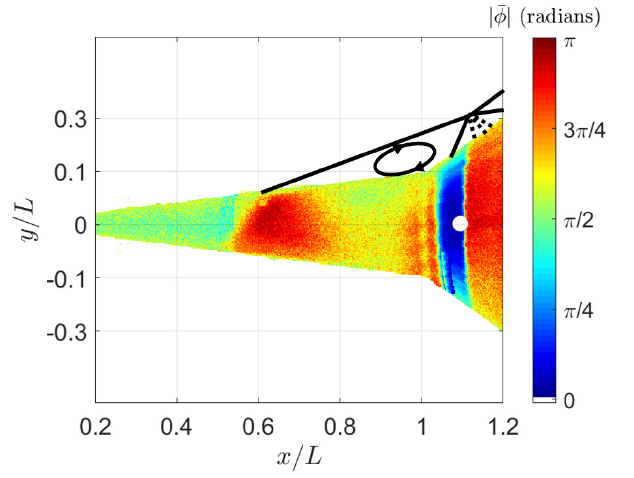
Figure 7. Mean | φ | contour for low-frequency (i.e., 50 < f < 1000 Hz)